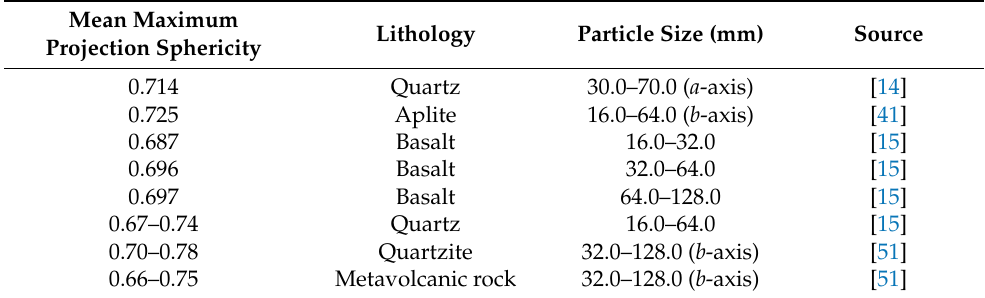
Table 1. Mean Values of Maximum Projection Sphericity from Isotropic Fluvial Gravels Taken from Downstream